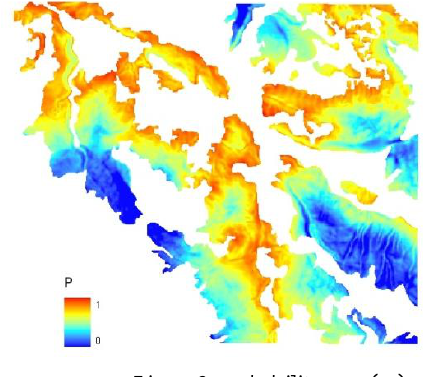
Figure 2: probability map (p ij )